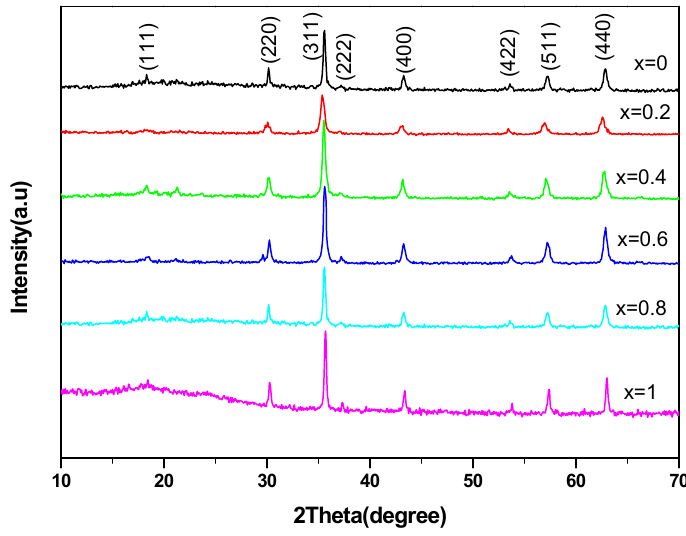
Fig. 1 XRD powder diffraction patterns of Ni x Co 1 − x Fe 2 O 4 (x=0, 0.2, 0.4, 0.6, 0.8, 1) specimens.